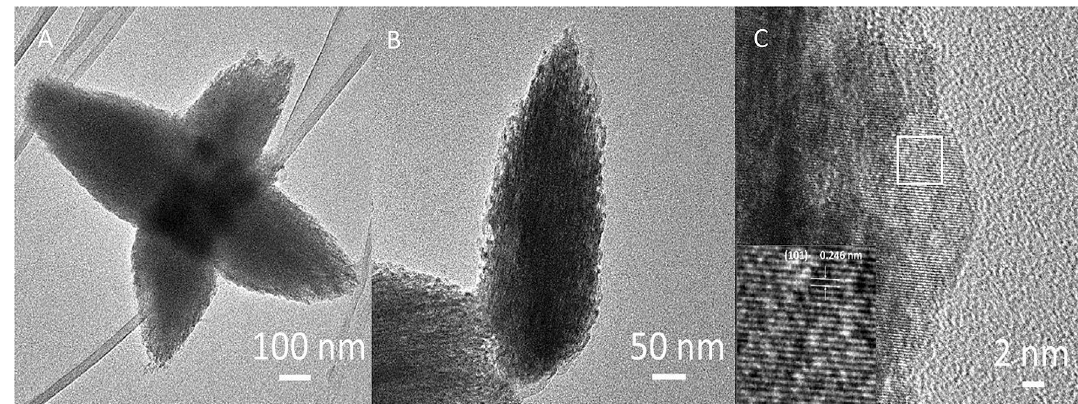
Figure 2. TEM images of ZnO nanoparticles with different magnifications ( A – C